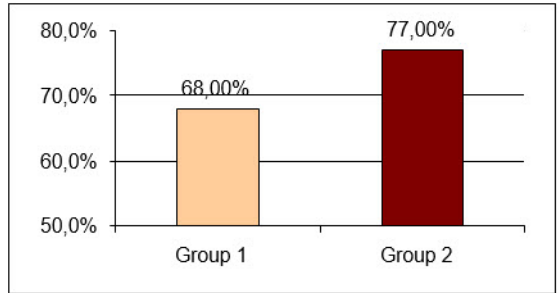
Figure 5. The success indicator of ver- bal-logical thinking in children of senior pre- school age